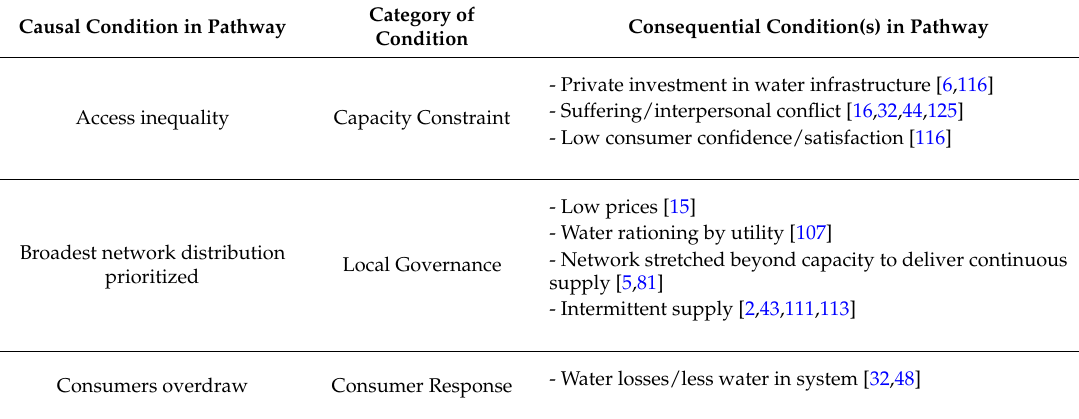
Table 2. Pathways between Conditions of Intermittent Water Supply.